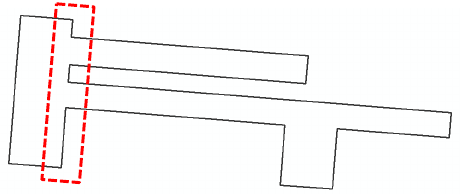
Figure 4. Example of short section and parallel / vertical section of traffic marking (sign of “Stop”)